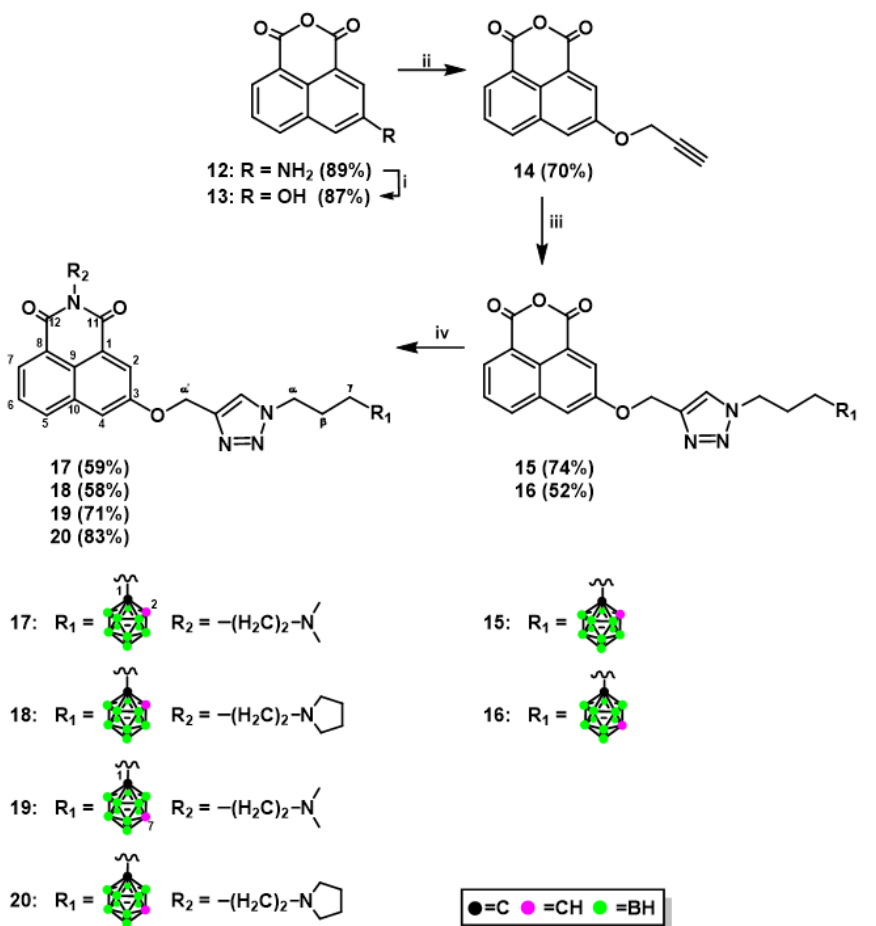
Scheme 2. Synthesis of naphthalimide– ortho- / meta -carborane conjugates 17 – 20 : Reagents and